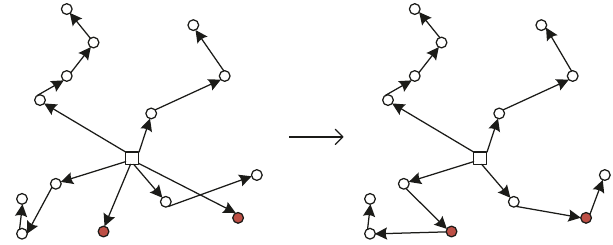
Figure 4: Short-route improvement